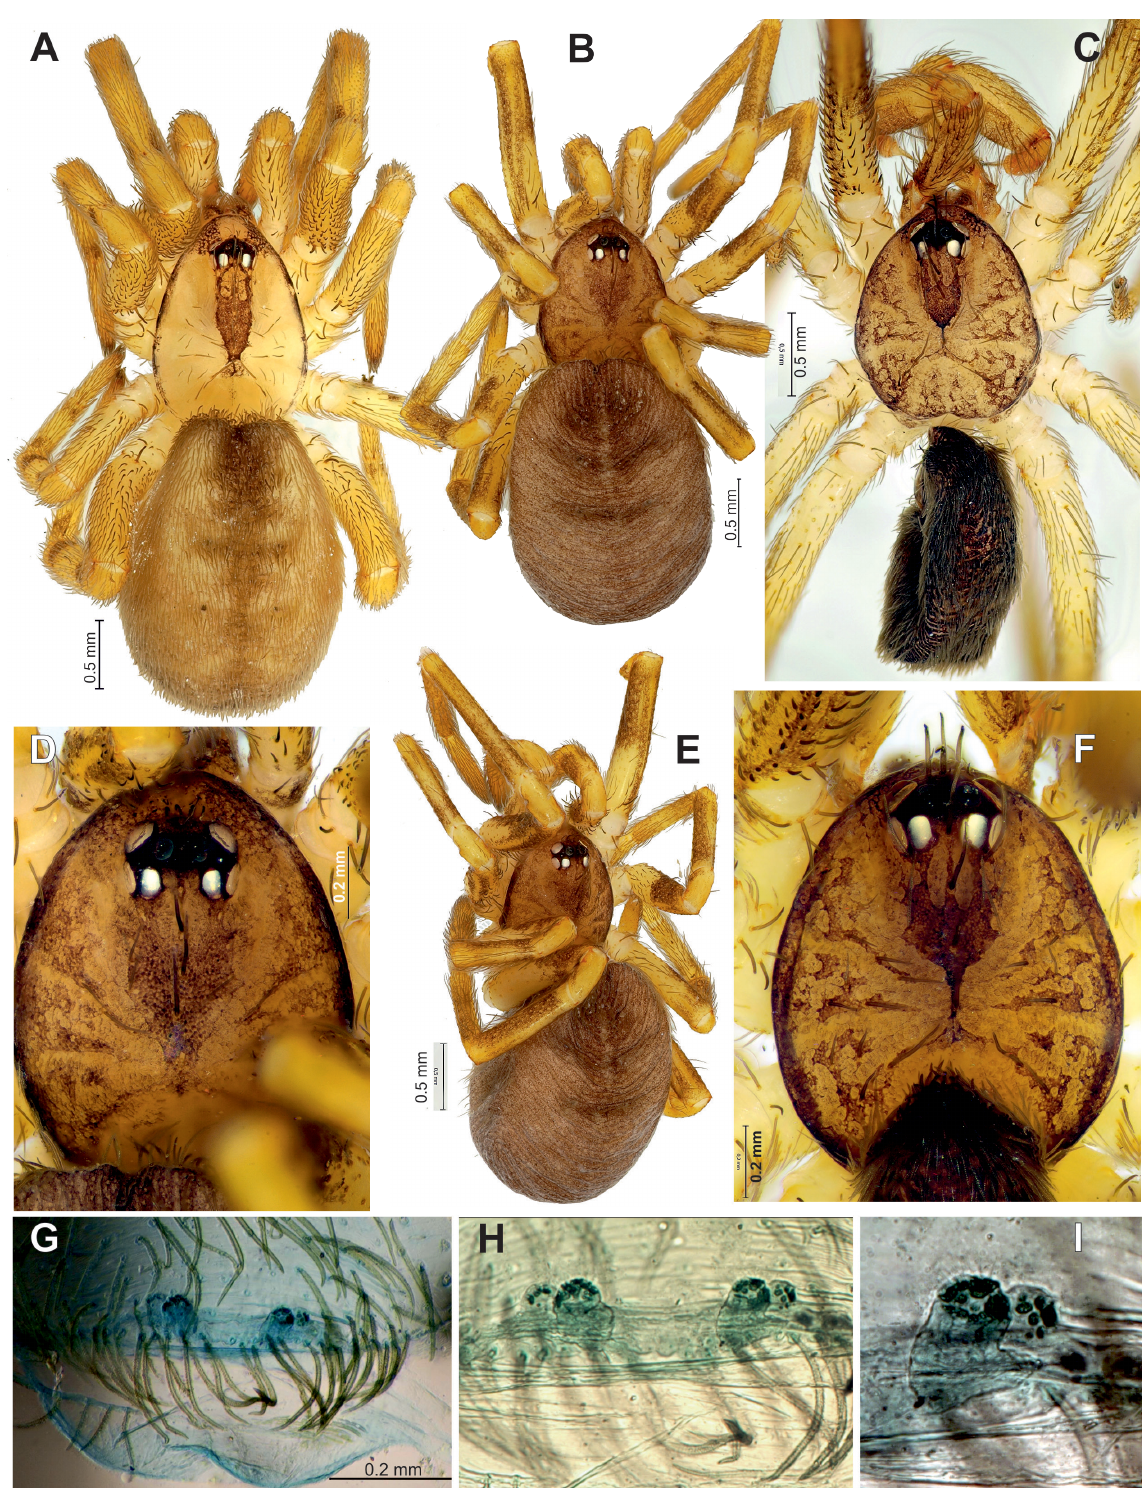
Fig. 12. Somatic characters and endogyne of Zaitunia minoica sp. nov., paratypes, ♀♀ ( A–B , D–E , G – I ) and holotype, ♂ ( C , F ). — A – C . Habitus, dorsal. D , F . Prosoma, dorsal. E . Habitus, dorso-sublateral. G–H . endogyne, dorsal. I . right pair of receptacles, dorsal. Scale bars: a–C, e = 0.5 mm; D, F–G = 0.2